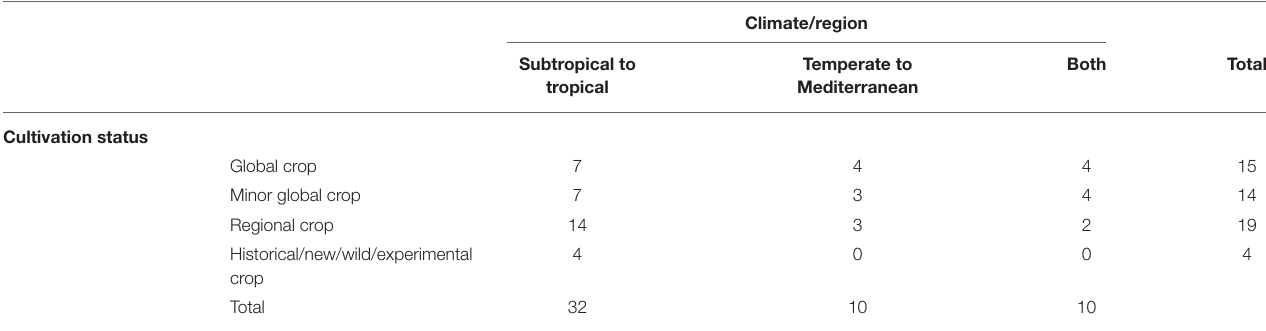
TABLE 3 | Region and cultivation status of perennial staple